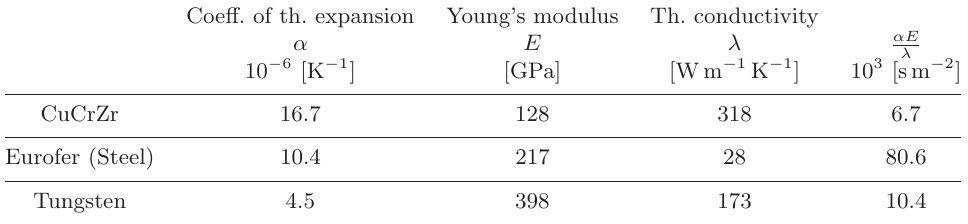
Table I. – Properties ( at 20 ◦ C ) of some materials employed in PFCs [5,6] . Coeff. of th.